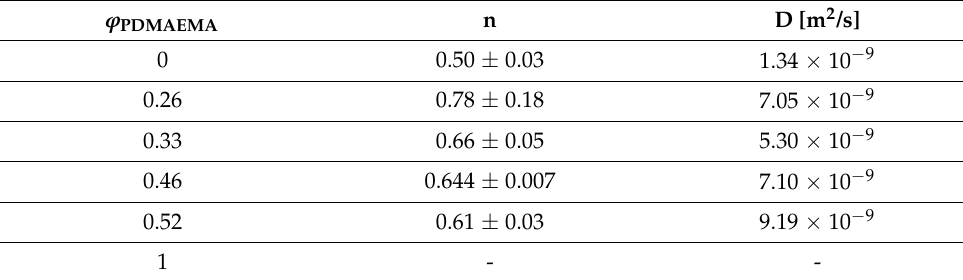
Figure 2. Swelling kinetics of the PDMAEMA/PAAm IPNs in water. For comparison, the PAAm single network swelling curve is also provided. Table 1. n and D values for PDMAEMA/PAAm IPNs and PAAm